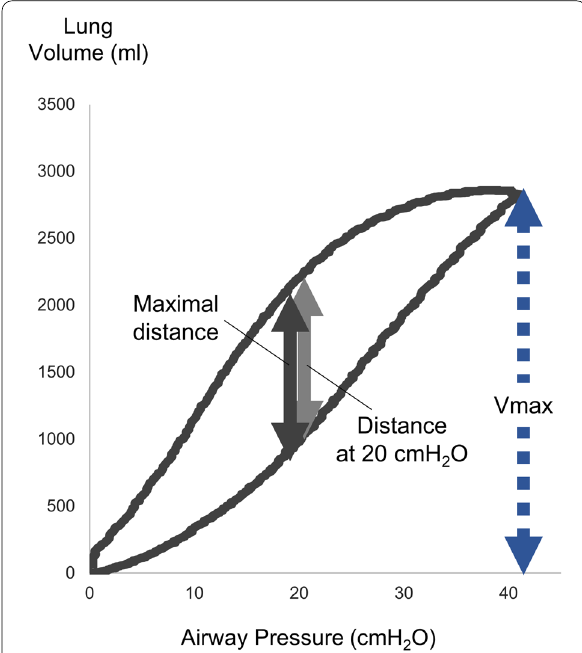
Fig. 1 The respiratory system quasi-static pressure–volume curve and recruitment-to-inflation ratio. The respiratory system quasi-static pressure–volume curve was recorded using an automatic ventilator tool for low-flow inflation from 0 to 40 cm H 2 O and low-flow deflation from 40 to 0 cm H 2 O, with a constant pressure variation of 2 cm H 2 O/s. The evaluation parameters in the pressure–volume curve were as follows: volume difference between the inspiratory and expiratory limbs at 20 cm H 2 O (distance at 20 cm H 2 O); normalized distance at 20 cm H 2 O, which is the distance at 20 cm H 2 O weighted by the maximal volume (V max ); maximal volume difference between the inspiratory and expiratory limbs at the same pressure (maximal distance); and normalized maximal distance, which is the maximal distance weighted by the V